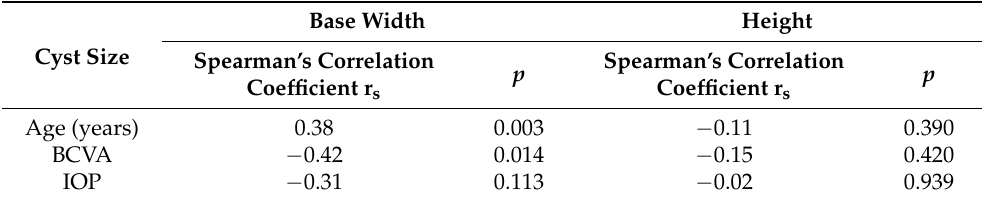
Table 2. Correlation between cyst size and age, best corrected visual acuity, and intraocular